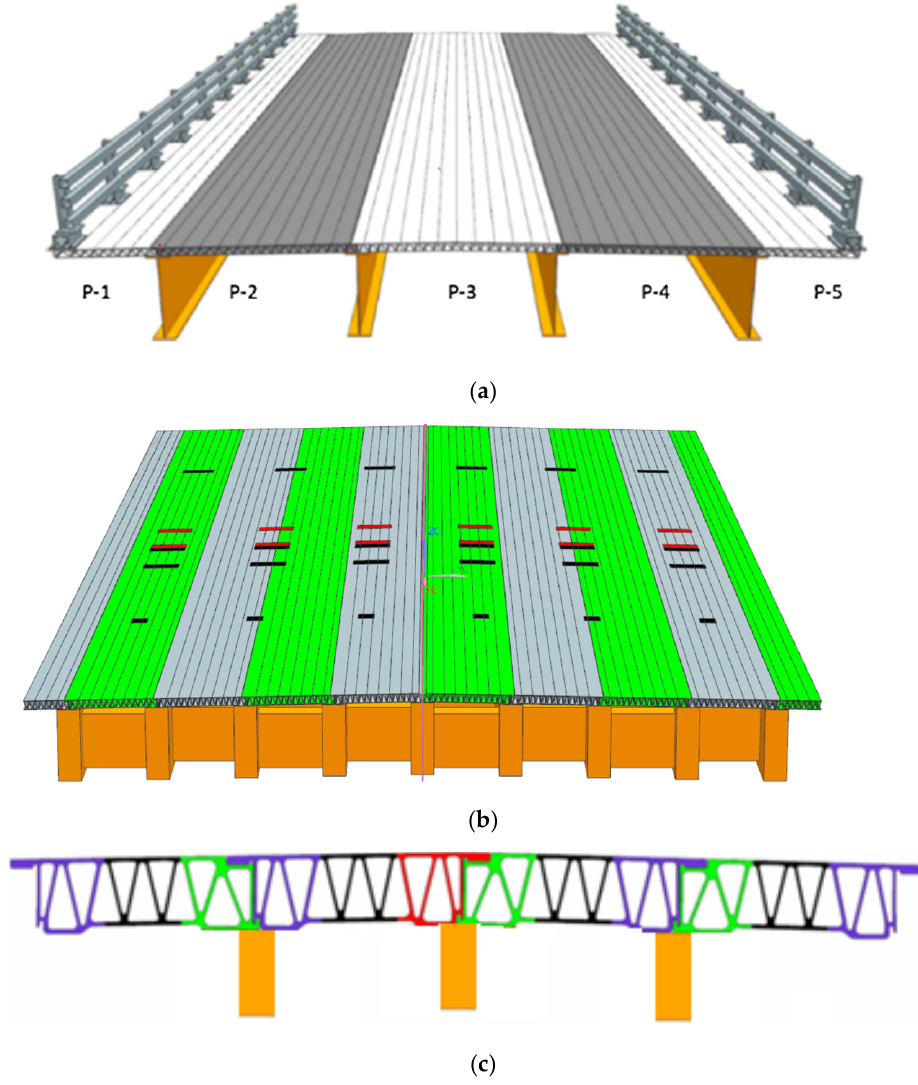
Figure 2. Schematic view of the studied bridges: ( a ) Aluminum deck supported by four-steel beams, ( b ) aluminum deck supported by nine-glulam timber beams and ( c ) typical male–female assembled aluminum extrusions.